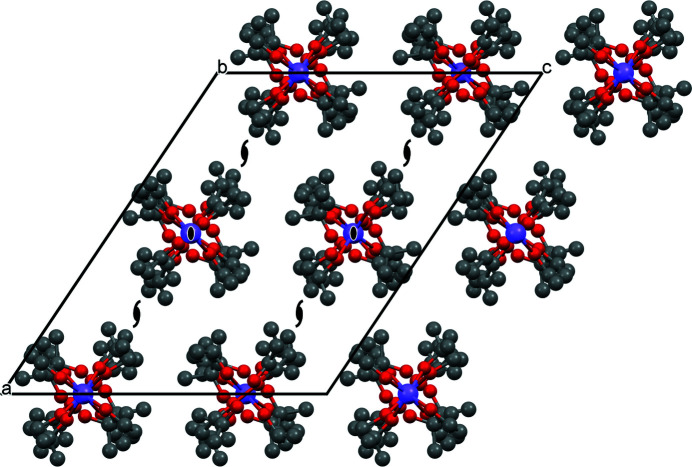
The crystal structure of NaOiPr·5iPrOH (space group C2/c, view along the chains and view direction [00]). The chains are located on twofold rotation axes, in contrast to the 21 screw axes for NaOnPr·2nPrOH (see Fig. 10 ▸
b).